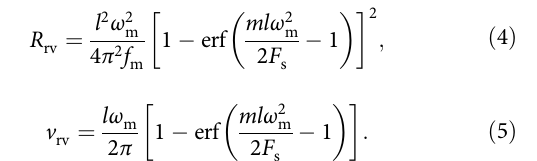
ffiffiffiffiffiffiffiffiffiffiffiffi p F = mr Þ and s ffiffiffiffiffiffiffiffiffiffiffiffi p F = mr Þ . The s